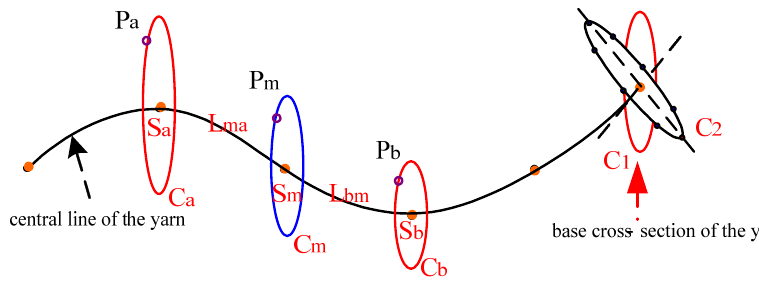
Figure 12. The method for generating a base cross-section by two known ones.